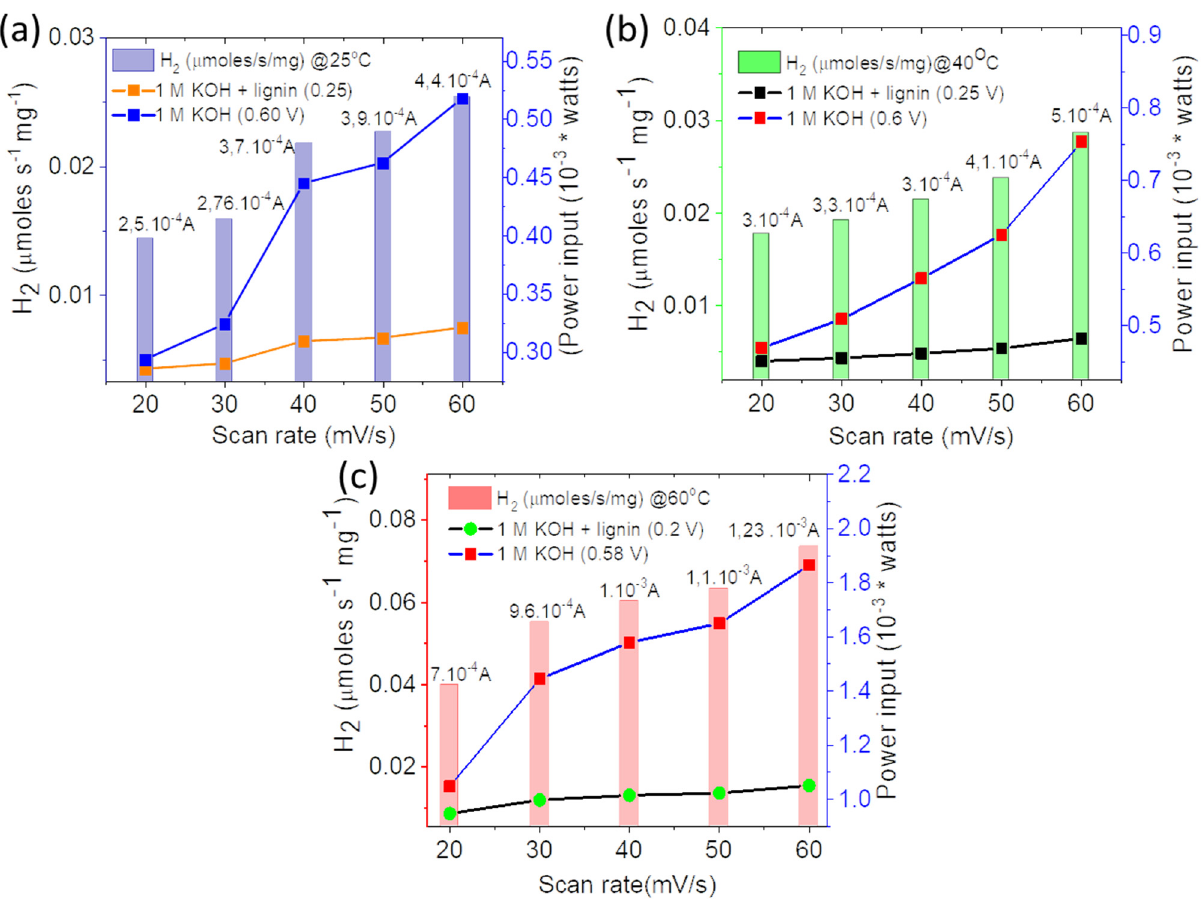
Figure 9. ( a – c ) Theoretical hydrogen generation ( µ moles s − 1 mg − 1 ) in conventional water oxidation and in lignin electro-oxidation at different scan rates.